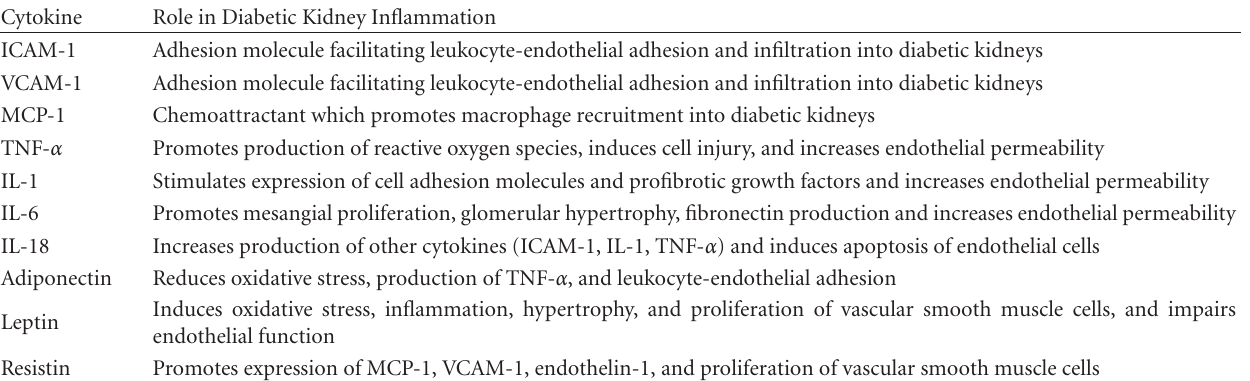
Table 1: Cytokines involved in Diabetic Kidney